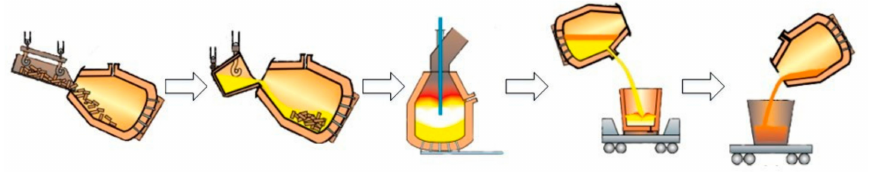
Figure 1. Diagram of the smelting process for converter